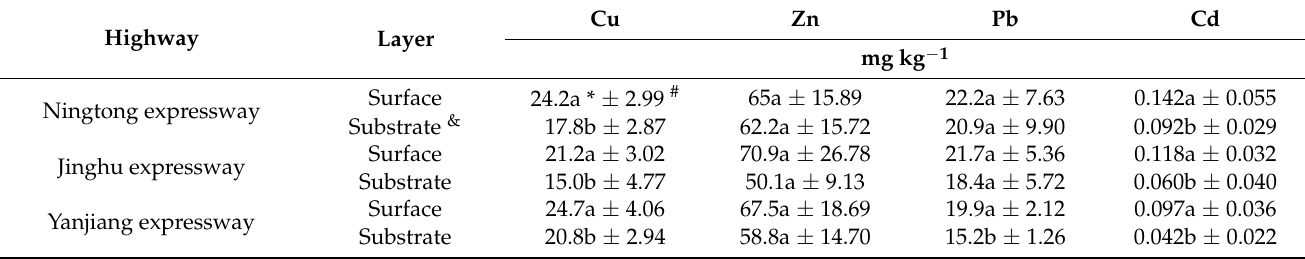
Table 2. Comparison between heavy metals in surface and in subsoils at three highways. Highway